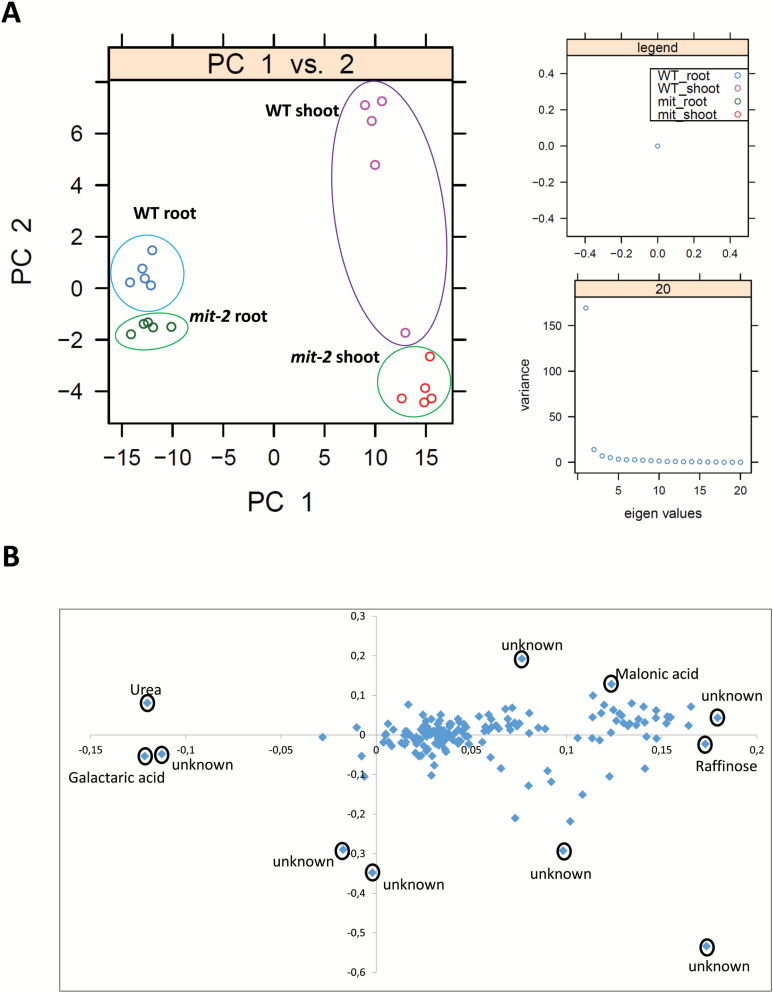
Principal component analysis (PCA) of the metabolomic data set of root and leaf tissues of mit-2 and WT plants. (A) PCA of metabolite data of five independent biological replicates. Data are median centred and log10 transformed. All 159 metabolites were used to perform the analysis. PC1, first principal component; PC2, second principal component. (B) Corresponding loading plot of all metabolites characterized by metabolomic analysis. Metabolites responsible for the PCA separation of the analysis are named in the graph. (This figure is available in colour at JXB online.)